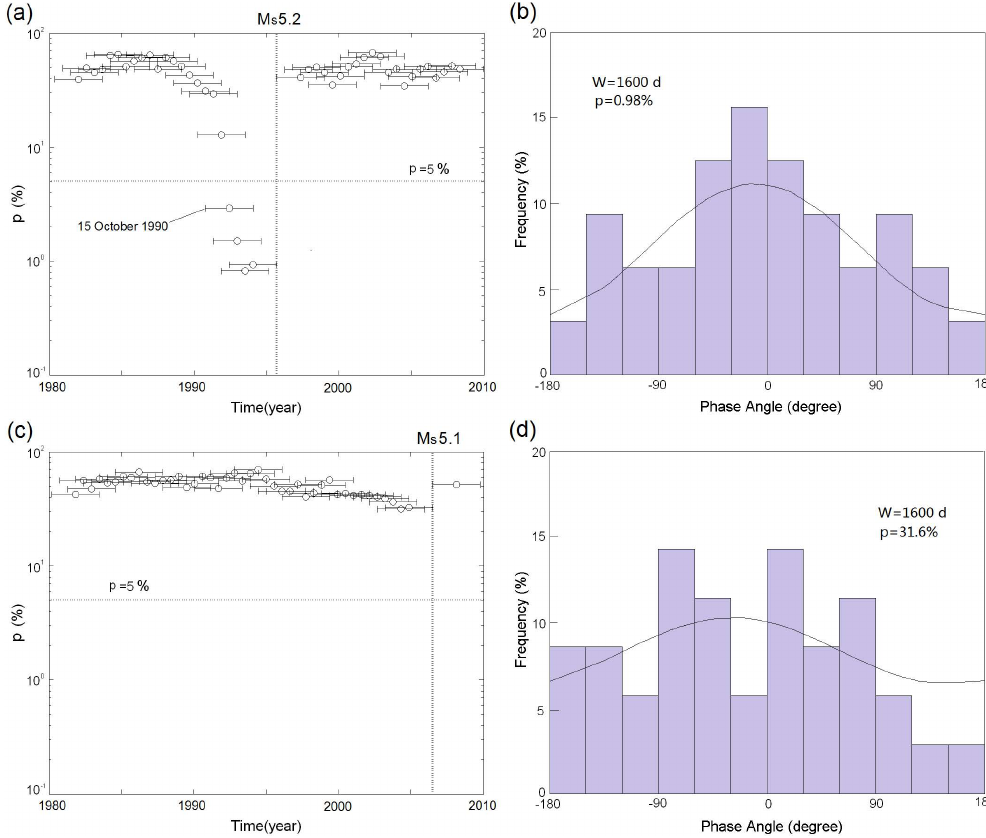
Fig. 7. (a) Variation of p value with time in the Cangshan region. The time window length, indicated by a horizontal line, is 1200 days, and the step length is 200 days. (b) Phase angle frequency change for events during the period of 1600 days before the Cangshan M s = 5.2 earthquake. The fine solid curve signifies a sinusoidal function which corresponds to the least square fit to the change. The fitting time window is a full period of sinusoidal function. (c) Variation of p value with time in the Wenan region. The time window length, indicated by a horizontal line, is 1200 days, and the step length is 200 days. (d) Phase angle frequency change for events during the period of 1600 days before the Wenan M s = 5.1 earthquake. The fine solid curve signifies a sinusoidal function which corresponds to the least square fit to the change. The fitting time window is a full period of sinusoidal